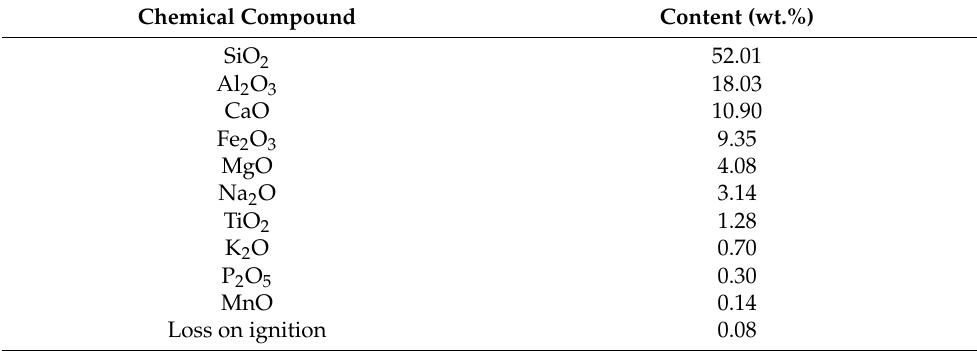
Table 2. Chemical analysis by XRF of basalt. Chemical